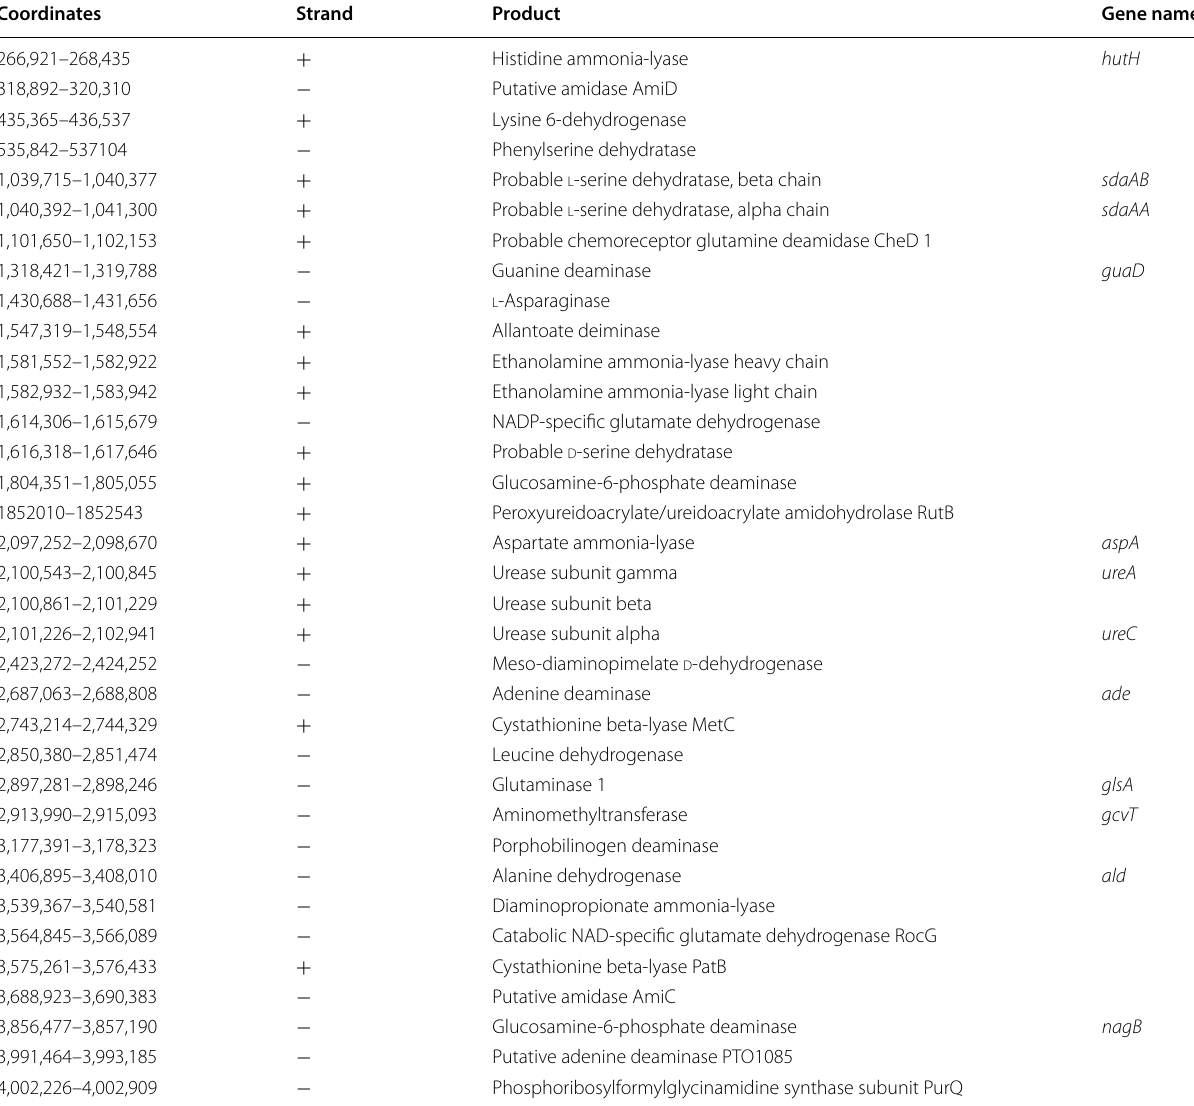
Table 3 Genes involved in production of ammonia and deamination of amino acids Coordinates Strand